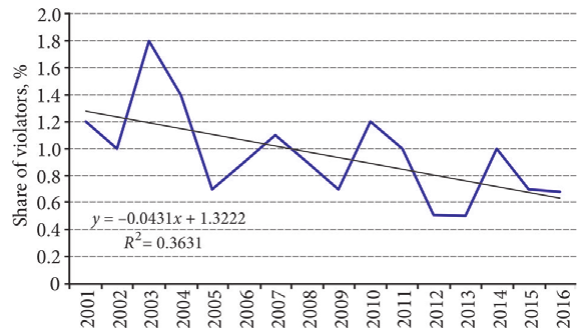
Fig. 5. Compliance of drivers with traffic lights in Estonia